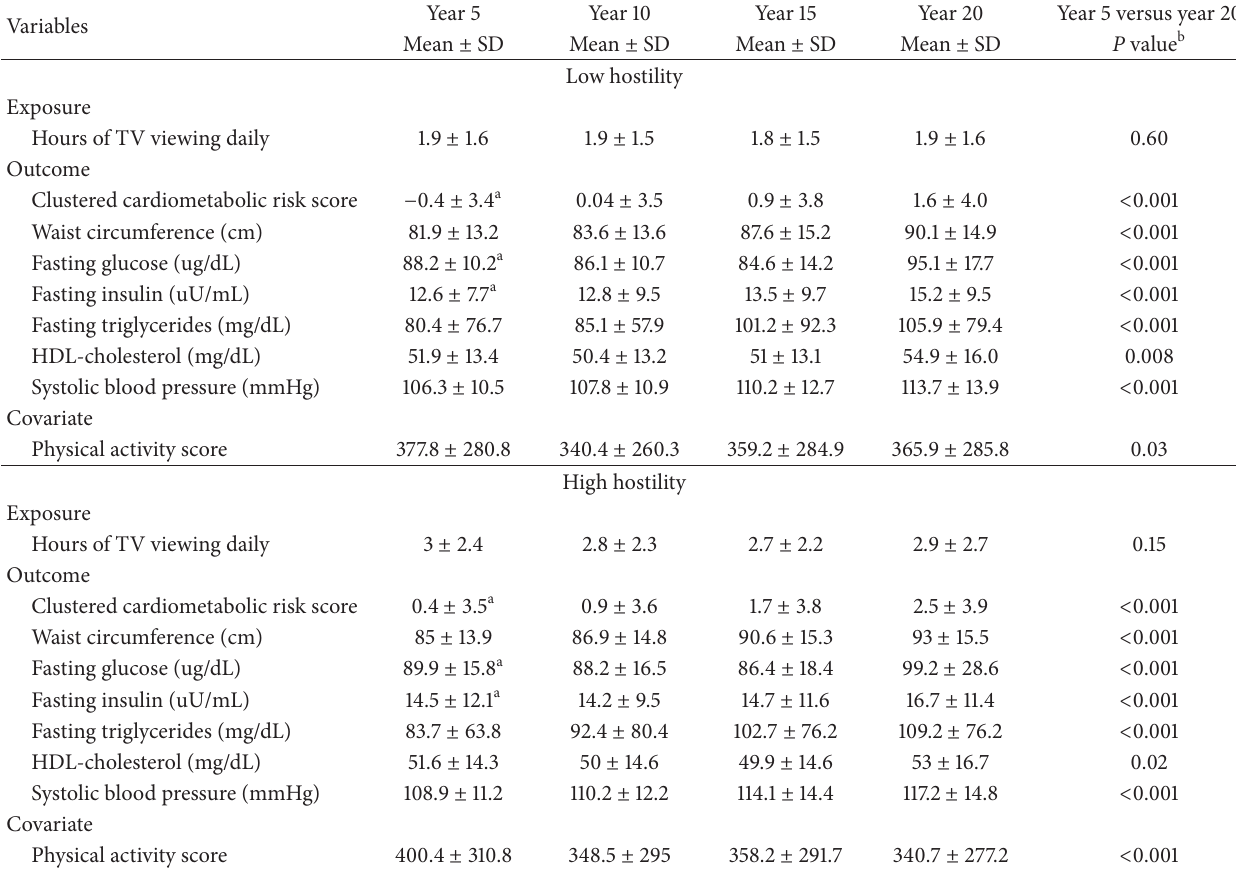
Table 2: Distribution of TV viewing, cardiometabolic risk variables, and physical activity score by hostility at examination year, CARDIA,